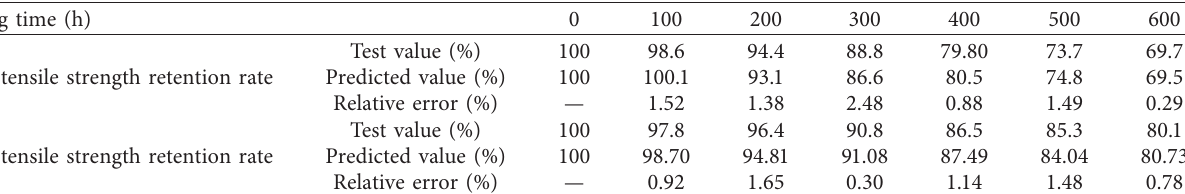
Table 4: The results of gray model